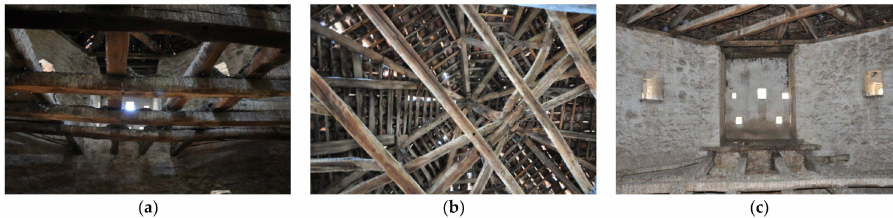
Figure 22. Tower Motrilja. ( a ) New mezzanine construction. ( b ) Roof construction. ( c ) Detail of the mezzanine (Photo source: private archive of Vladan